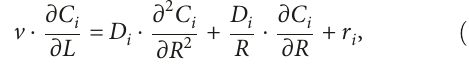
Figure 5: In fl uence of initial concentration of H degradation